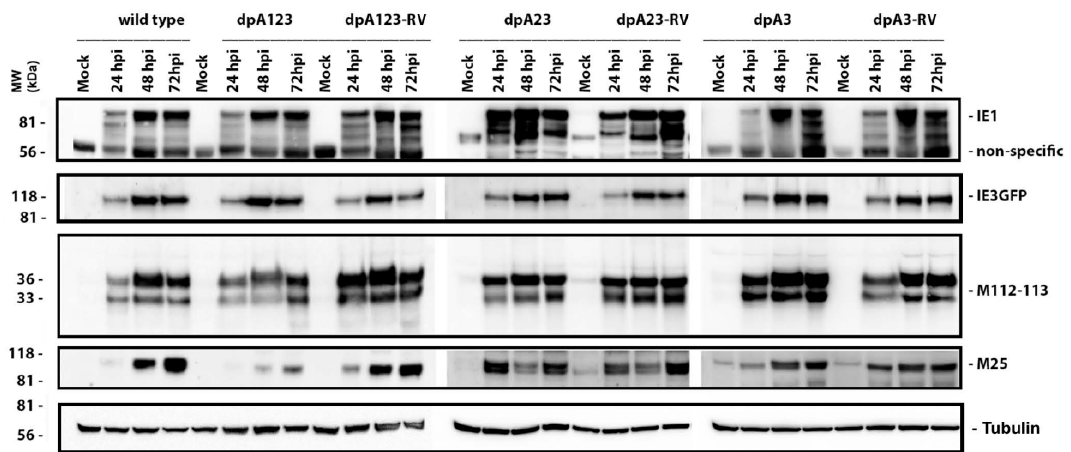
Figure 5. Viral protein production. NIH3T3 cells were infected with MCMVs (mutation, revertant, and wild-type) at an MOI of 0.1, and the whole-cell lysates were collected at the indicated time postinfection. The samples were loaded to run on SDS-PAGE, and the proteins were transferred to a nitrocellulose membrane for Western blot assay using the antibodies, as shown on the right side. Three independent experiments were performed, and one of the experiments is shown.